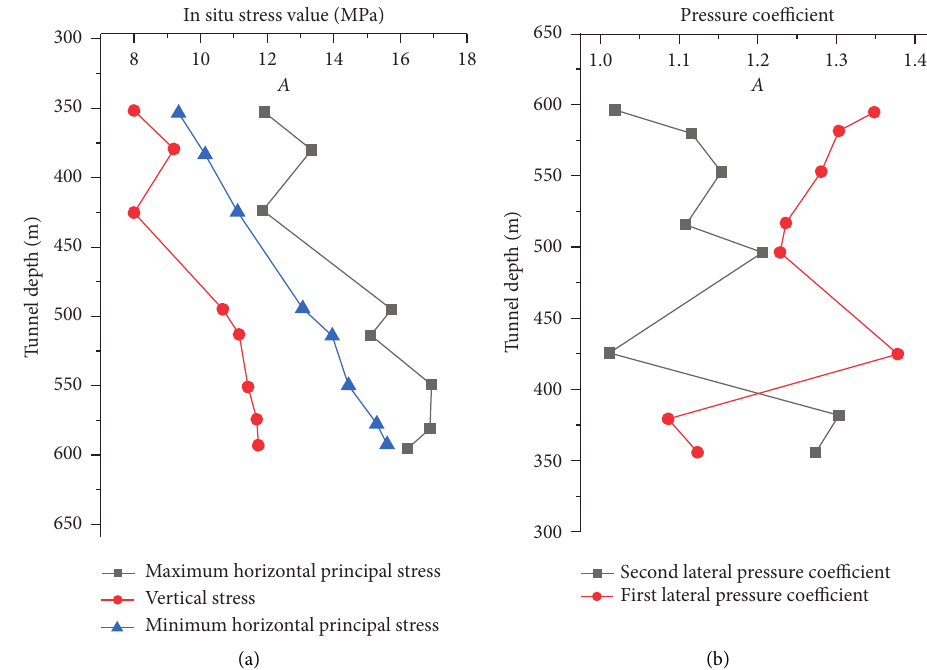
Figure 2: In situ stress test results: (a) in situ stress depth relationship; (b) lateral pressure coefficient depth